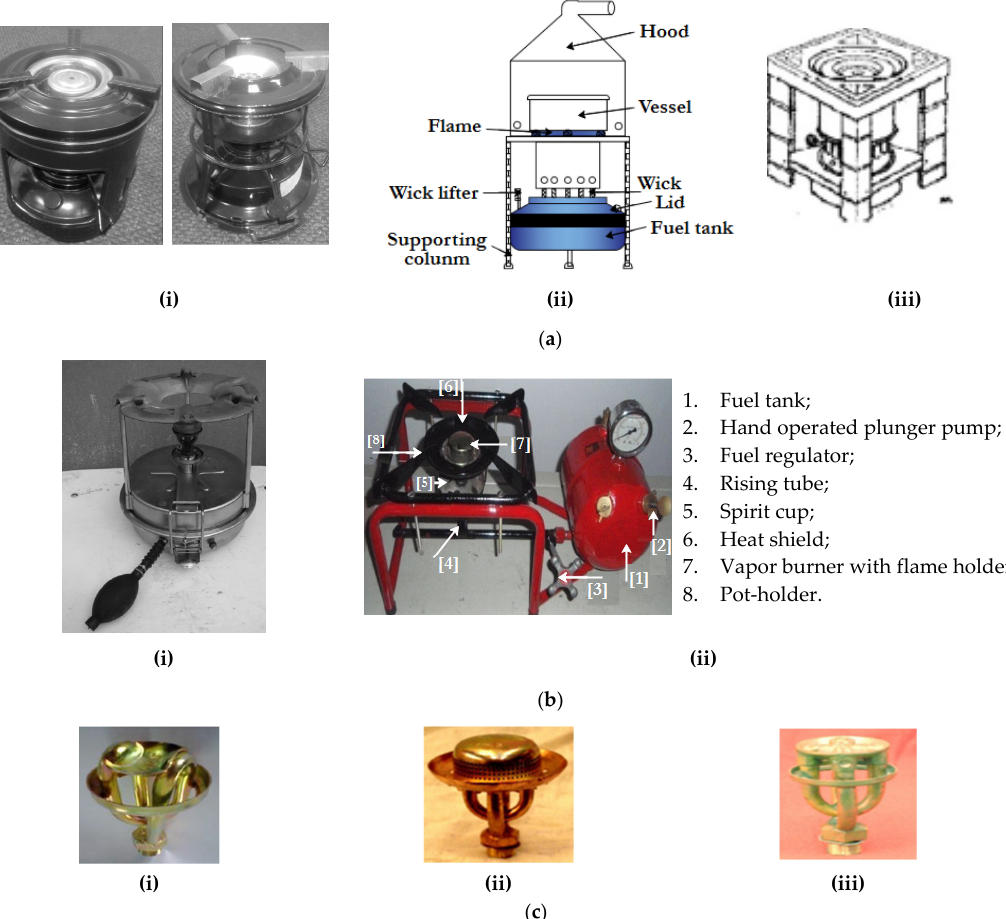
Figure 10. ( a ) Different designs of kerosene wick stoves—( i ) kerosene wick (woven fiberglass) stove [61], ( ii ) kerosene wick (10 no. of wick) stove [62] and ( iii ) kerosene wick (8 no. of wick) stove [63]; ( b ) Different types of kerosene pressurized stove—( i ) kerosene pressure stove (Roarer type burner) [61] and ( ii ) kerosene pressure stove [33]; and ( c ) Kerosene pressure cook-stove burners [33]—( i ) Venus burner, ( ii ) Silencer type burner and ( iii ) Roarer type burner.